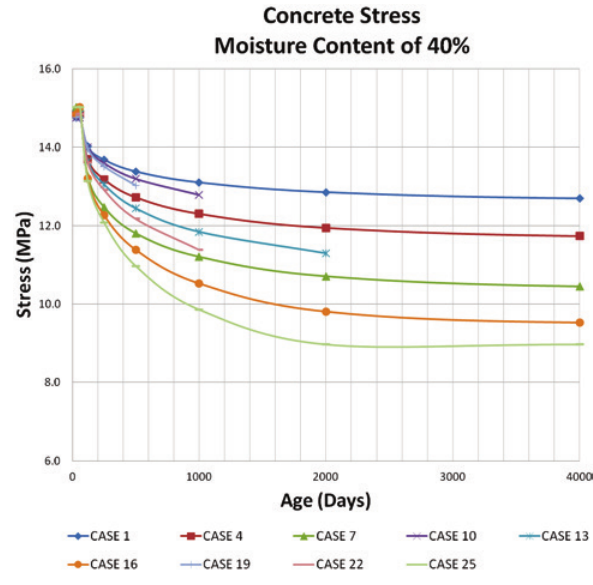
Figure 10 Evolution of stresses on the concrete for 40% moisture